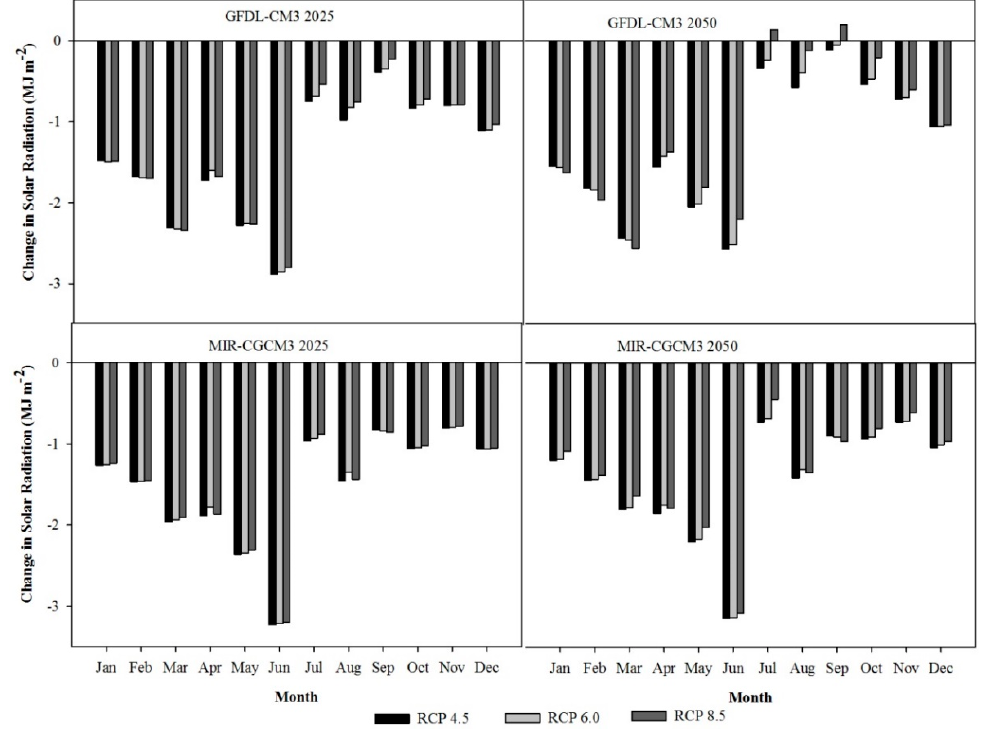
Figure 2. Changes in monthly SRAD (MJ m − 2 ) as projected for 2025 and 2050 based on three RCPs for two GCMs compared with 1961–1990 for Guanzhong Plain.